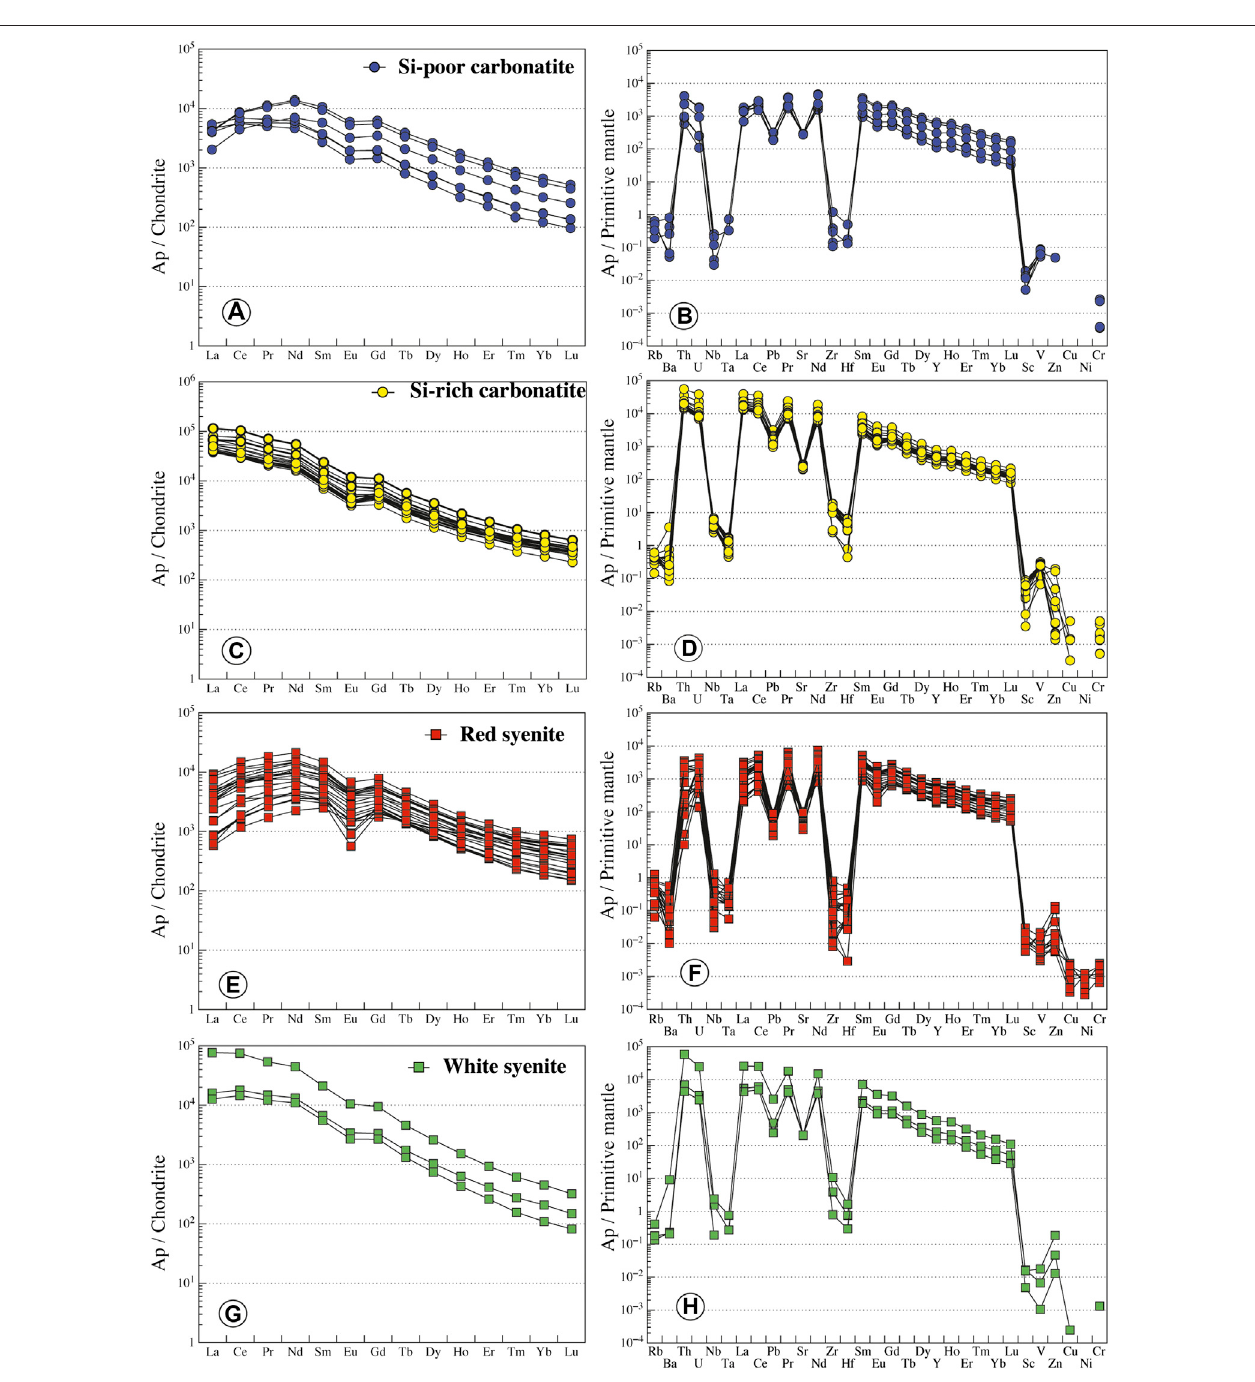
FIGURE 10 | Normalized REE and trace element contents of apatite from Ihouhaouene carbonatites and associated silicate rocks. Chondrite values and primitive mantle values are obtained from Sun and McDonough (1989).